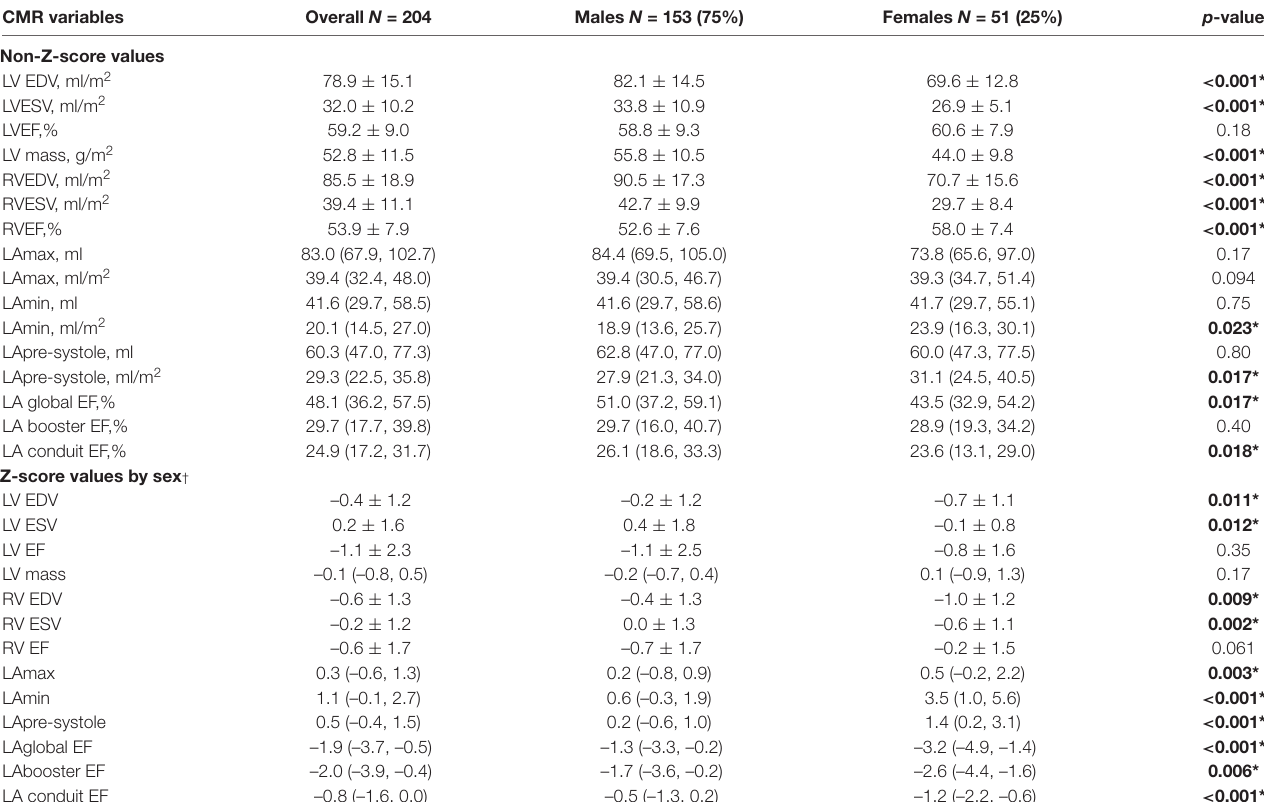
TABLE 3 | Baseline CMR chamber volumes and ejection fraction of the overall cohort and stratified by sex. CMR